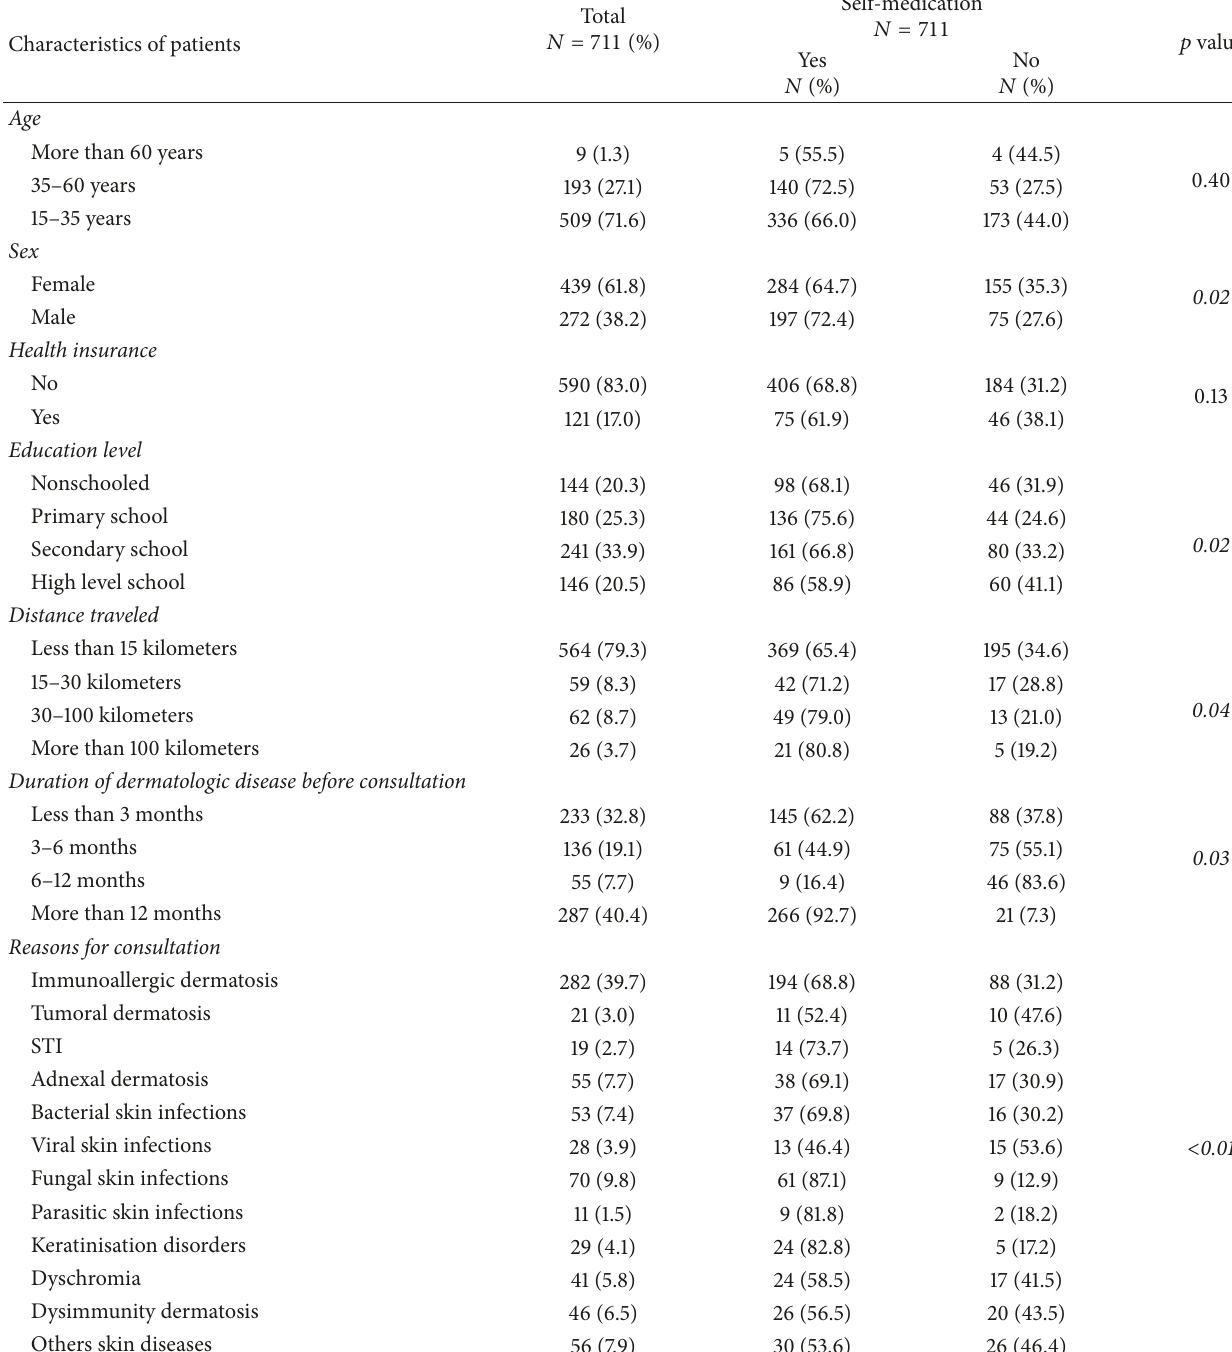
Table 1: Sociodemographic and clinical characteristics of patients with dermatologic diseases practicing self-medication in Lom´e, 2016.